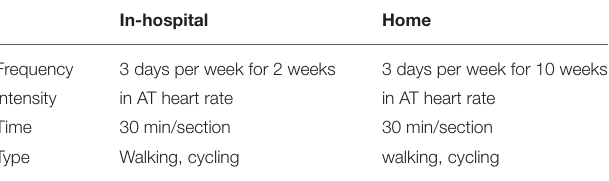
TABLE 1 | Frequency, intensity, time, and type of exercise